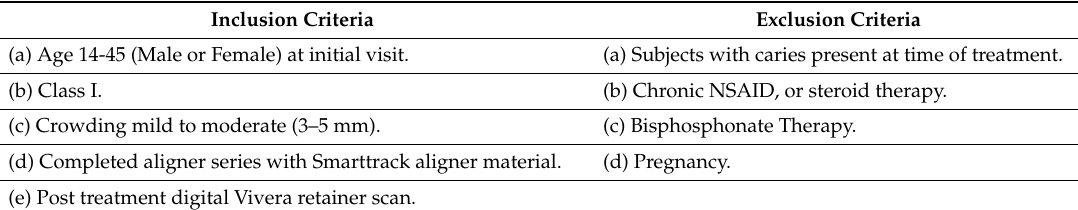
Table 1. Inclusion and exclusion criteria for study